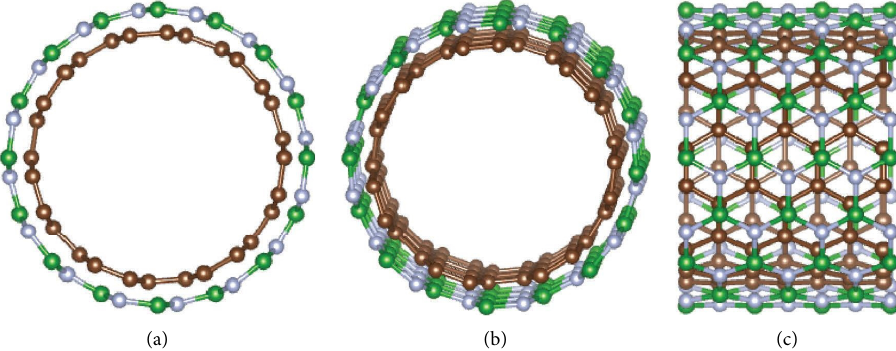
Figure 4: (a) Top view, (b) slanted view, and (c) side view of armchair CBNNT under 1.50nm IWD. Table 2: DWCBNNT before and after relaxation. IWD